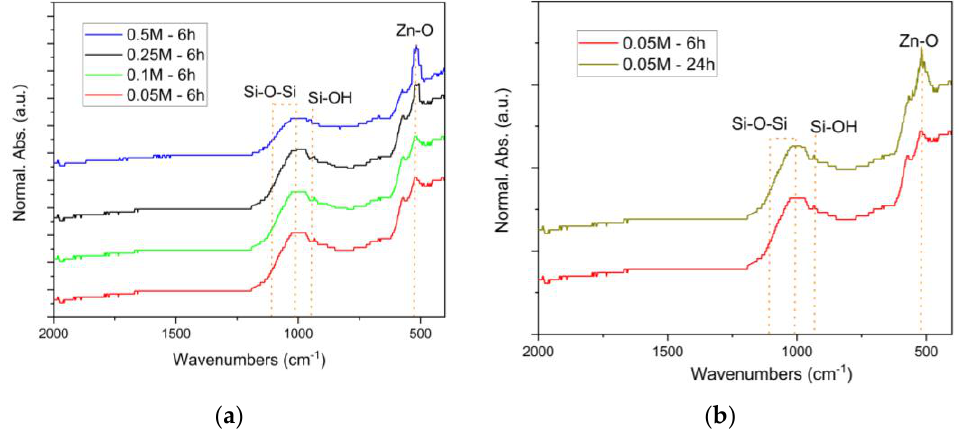
Figure 6. FTIR spectra of fibres coated for 6 h with ZnO using different concentrations of the precursor ( a ) and different deposition duration and the same concentration of the precursor ( b ).